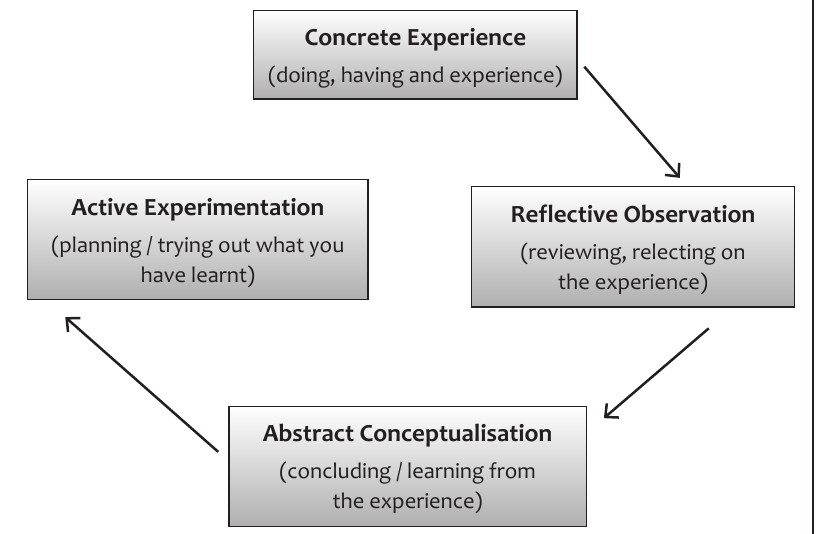
Figure 3: Kolb’s learning cycle (Kolb